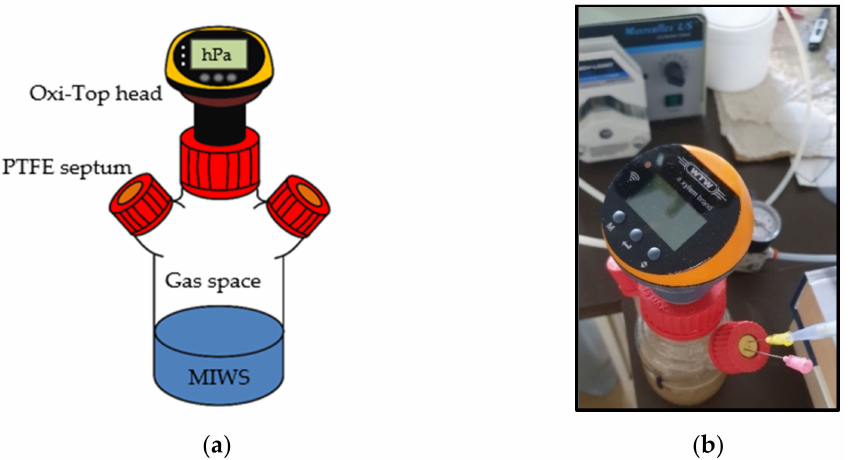
Figure 2. Schematic arrangement of the AD fermenter—manometric head system ( a ) and the actual arrangement during nitrogen injection ( b ).